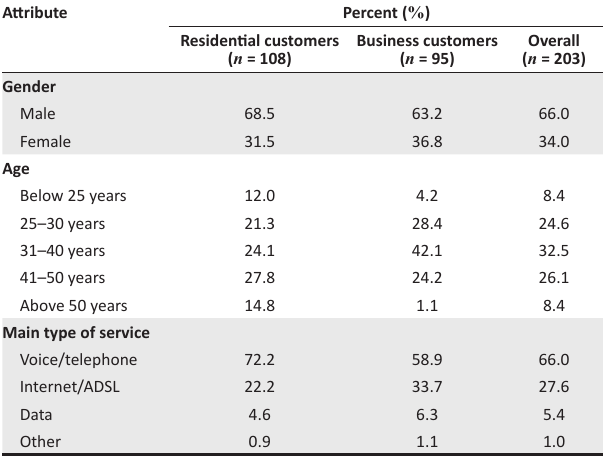
TABLE 2: Profile of the sample.